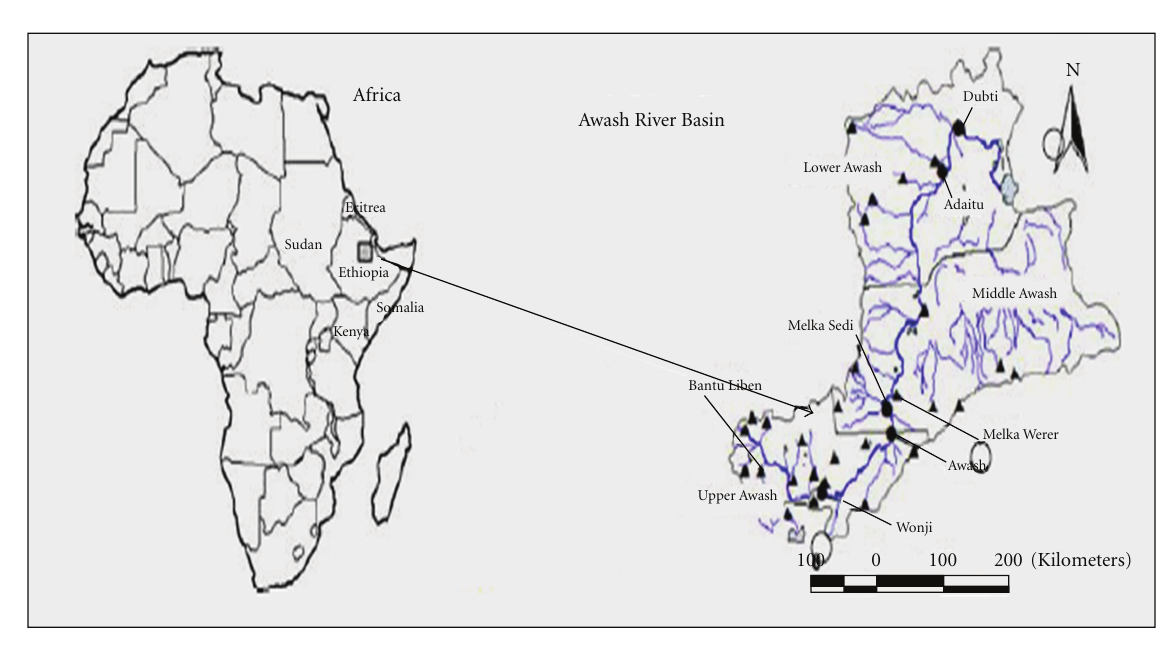
Figure 2: Awash River Basin (Source: